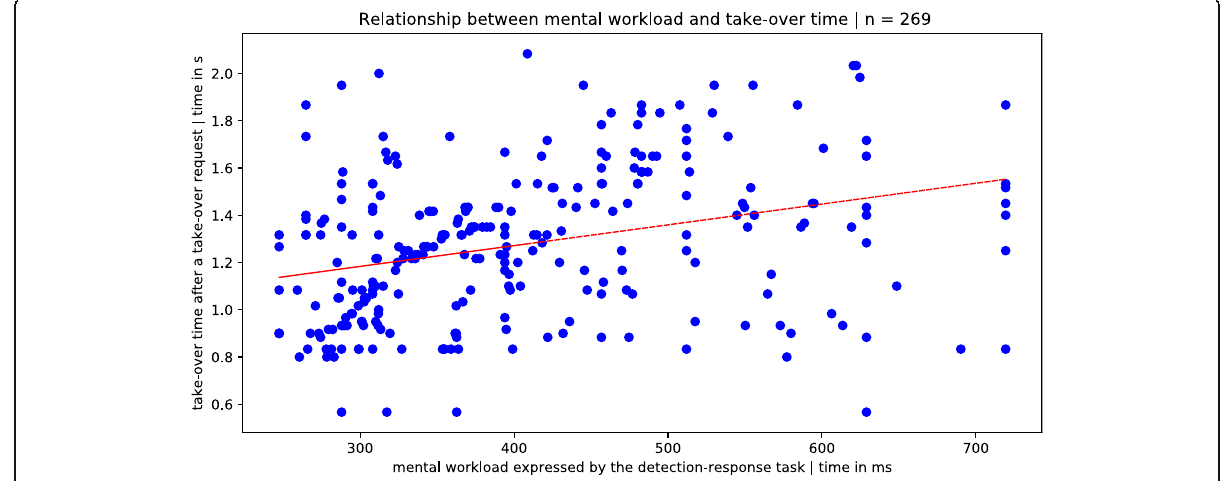
Fig. 9 Relationship between mental workload expressed by the detection-response task and